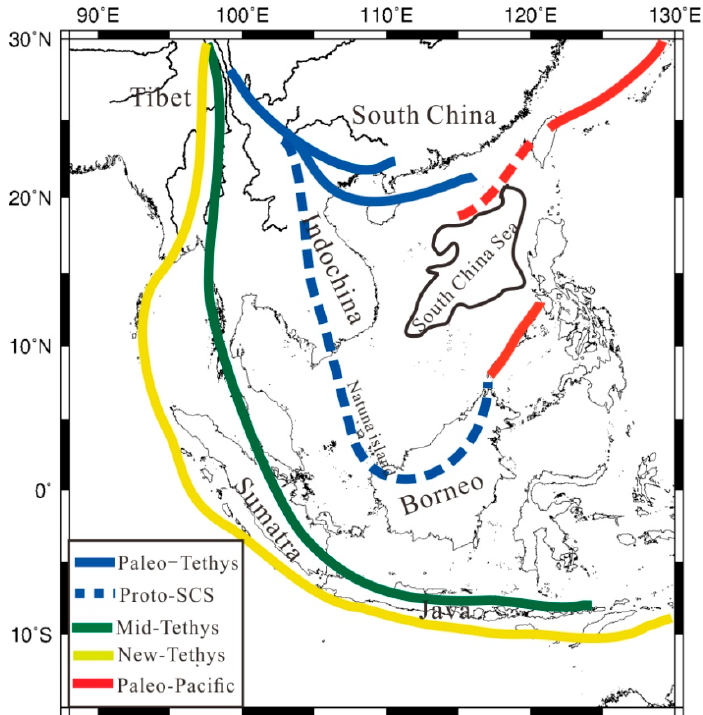
Figure 15. Schematic diagram of the spread of the PSCS with Tethys and the ancient Pacific in Southeast Asia (modified from Zhou et al. [8]).